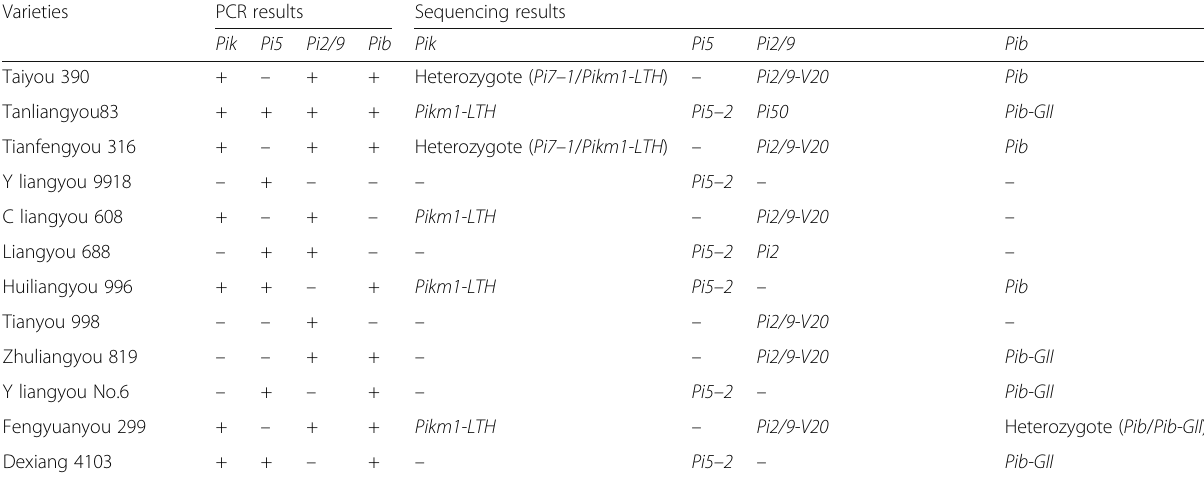
Table 1 The PCR and sequencing results of different haplotypes of 4 R -gene loci in 54 rice varieties. PCR: Polymerase chain reaction; +: PCR positive; − : PCR negative; LTH: Lijiangxintuanheigu (Continued) Varieties